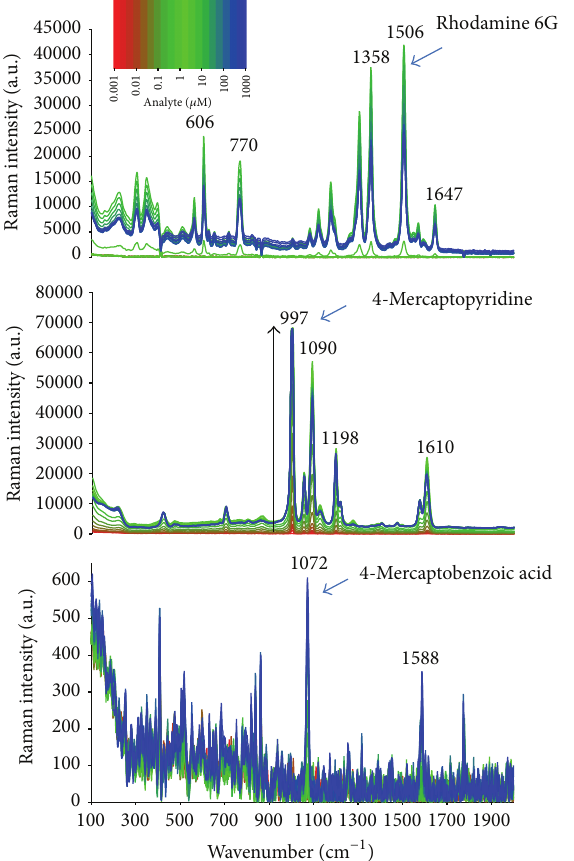
Figure 3: Raman scattering spectra of titrants (SERS labels) rho- damine 6G (R6G, top), 4-mercaptopyridine (MPY, middle), and 4- mercaptobenzoic acid (MBA, bottom) as these are titrated into ca. 1nM Au@Ag core-shell nanoparticles. Titrant concentrations are as indicated in color bar and range from 1nM (red) to 1mM (blue). Peaks are consistent with values reported in the literature [56]. The blue arrows indicate the peaks used for SERS integral intensity calculations.